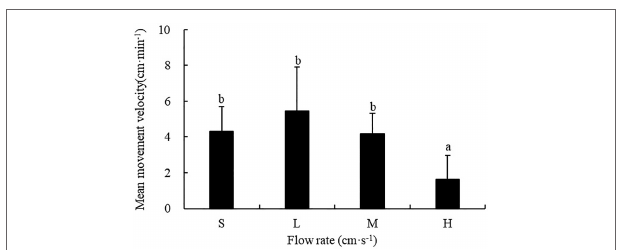
FIGURE 7 | Movement velocity of S. monotuberculatus at four different flow rates. S, L, M, and H represent the four flow rates: 0 cm/s, 4.7 ± 1.2 cm/s,